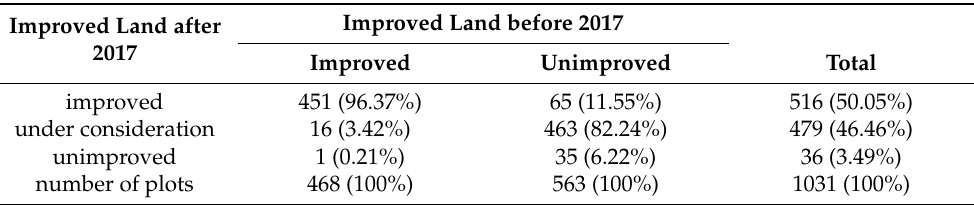
Table 2. A cross-analysis on the consistency of farmers’ behavior in land improvement.